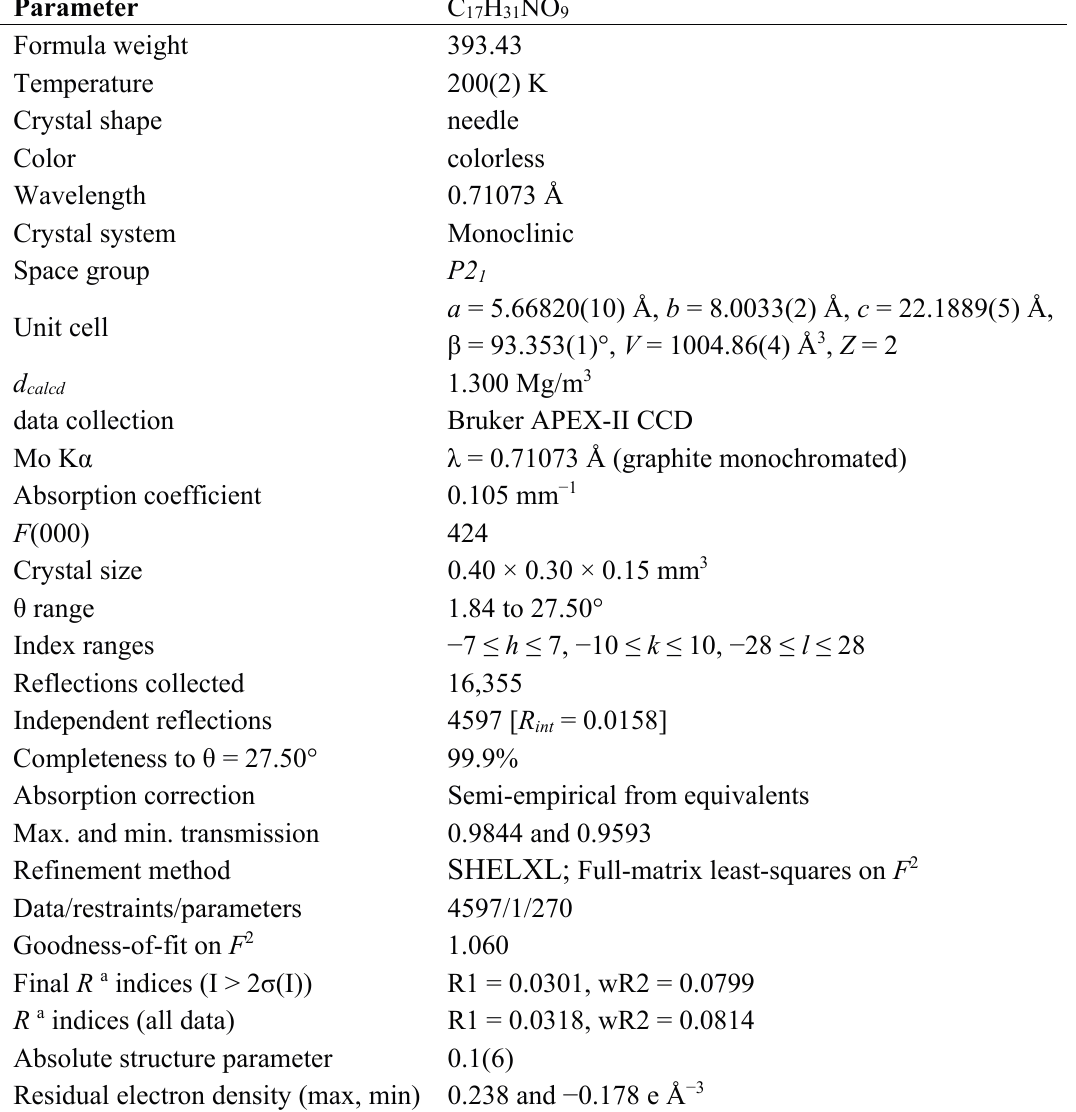
Table 1. Crystal data and structure refinement for 3 .